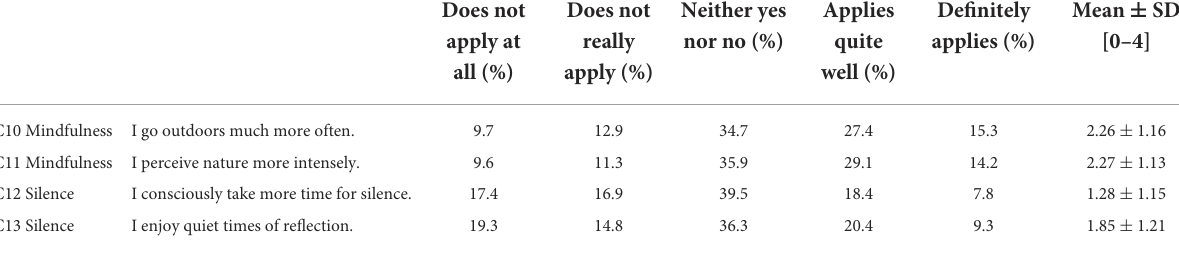
TABLE 2 Frequency distribution for the aspects of Nature/Silence